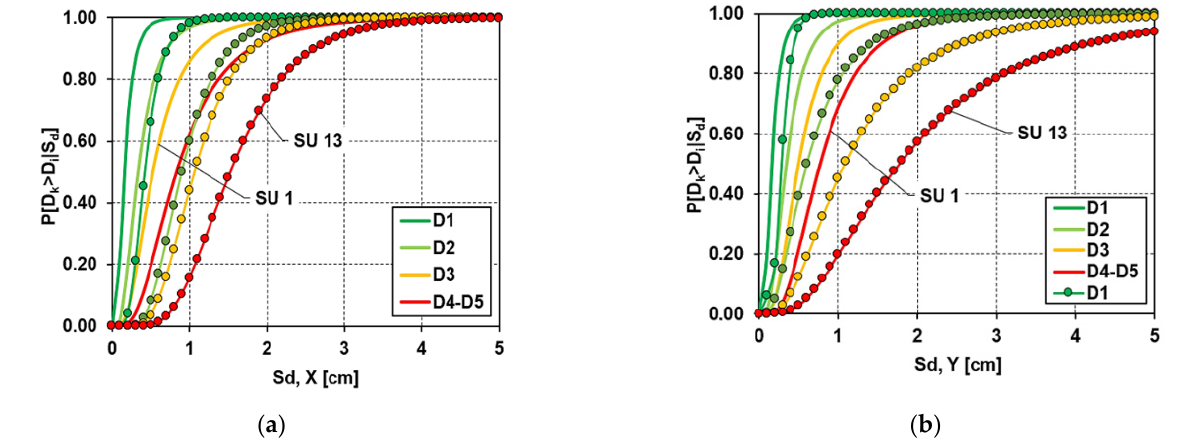
Figure 14. Influence of the structural positions on the fragility assessment of inspected SUs in ( a ) X direction and ( b ) Y analysis directions.